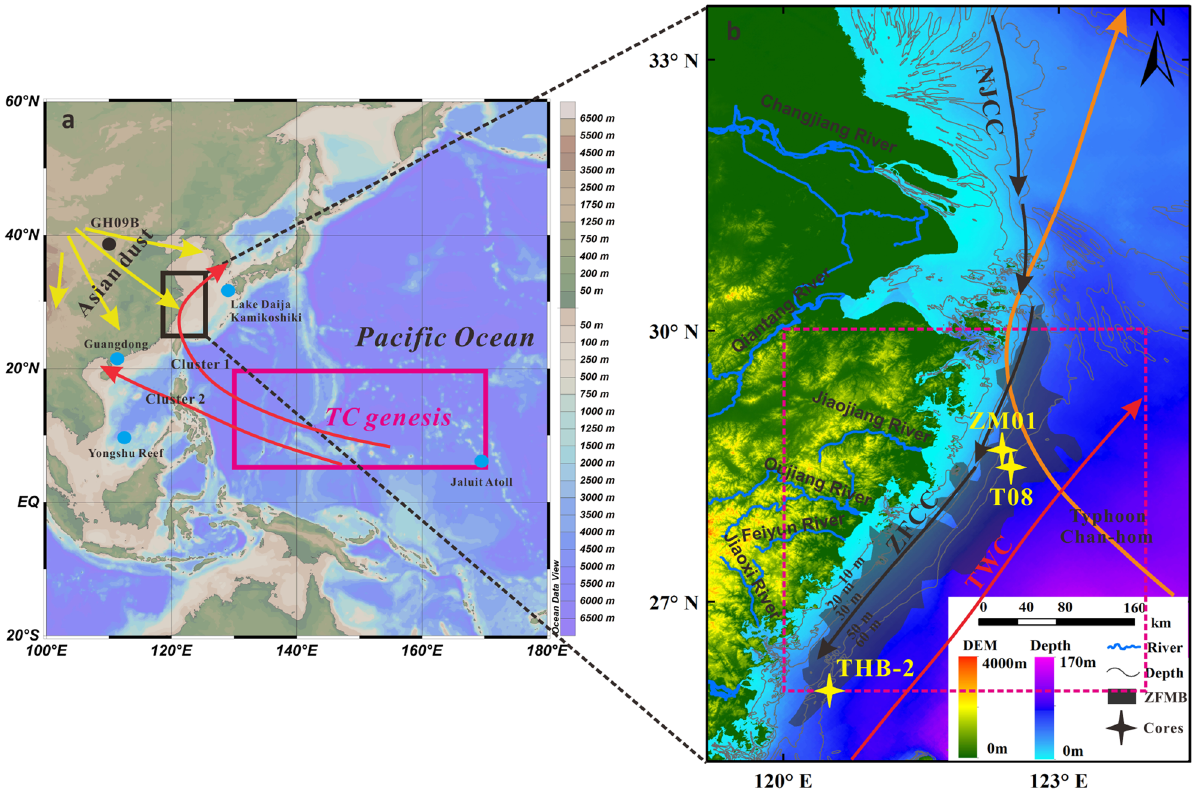
Fig. 1 Site location. a Overview map of the northwestern Paci fi c Ocean showing the region of TC genesis (red rectangle), main TC tracks (red arrows), published paleostorm records 18,27,30,54,55 (blue dots) and the schematic trajectories of Asian dust storms (yellow arrows). The location of the Asian dust proxy site from Lake Gonghai, northern China 66 (GH09B) used in this study is also indicated (black dot). b Locations of cores ZM01, T08 25 , and THB-2 38 (yellow stars). A simpli fi ed illustration of the Zhejiang-Fujian mud belt (gray area), instrumental wind speed area (red dashed box), and the track of 2015 CE Super Typhoon Chan-hom (orange arrow) are also shown. ZFCC Zhejiang-Fujian Coastal Current (black arrow), TWC Taiwan Warm Current (red arrow), NJCC Northern Jiangsu Coastal Current (black